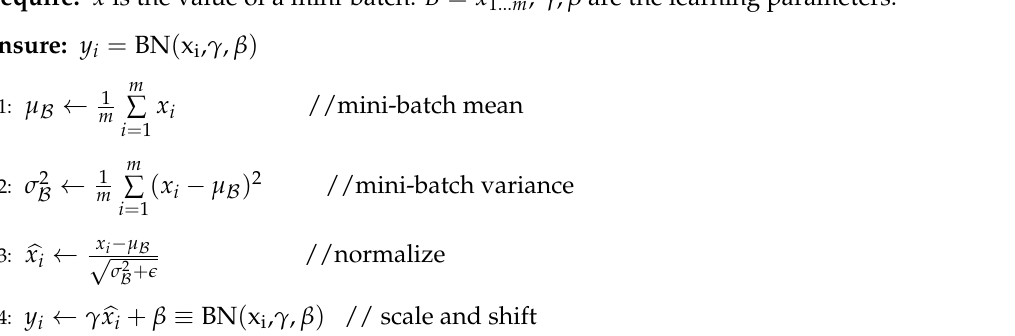
Algorithm 3 Batch normalization [51]: In the algorithm, let the normalized values be x (cid:98) 1... m and their linear transformations be y 1... m . The transformation is stated as: BN γ , β : x 1... m → y 1... m . This algorithmic procedure states that (cid:101) is a constant incorporated for numerical